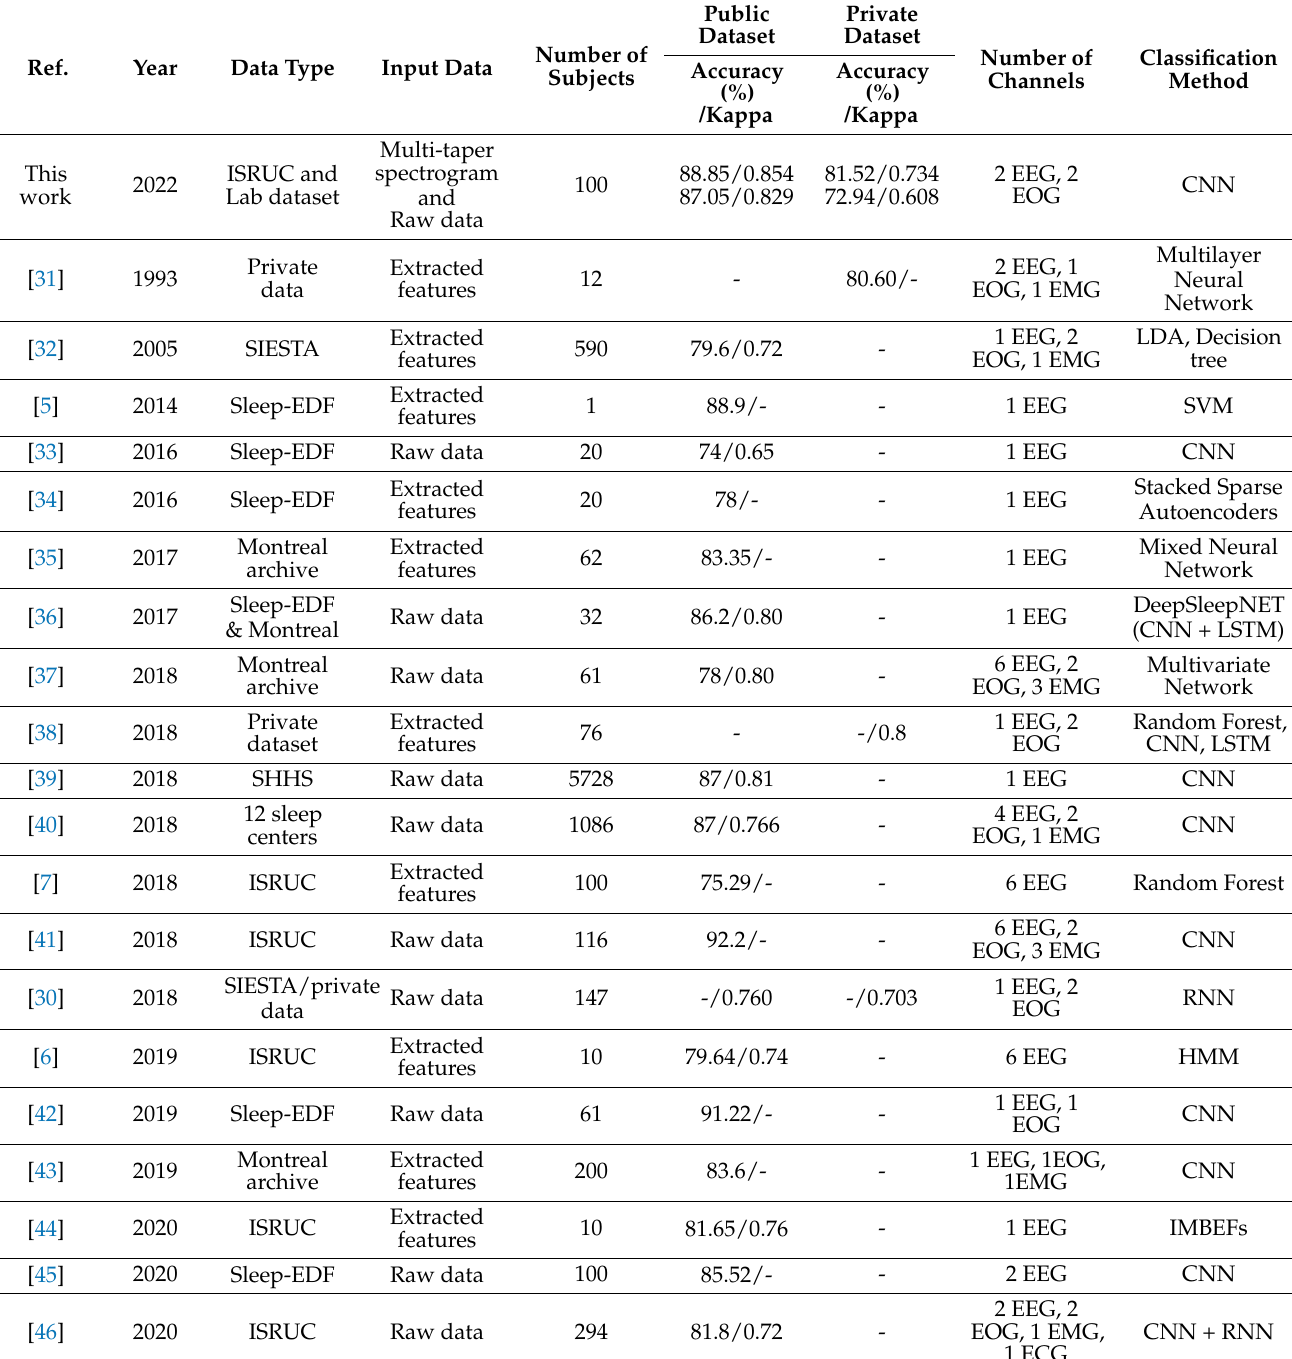
Table 4. Comparison of sleep-stage classification performance with prior